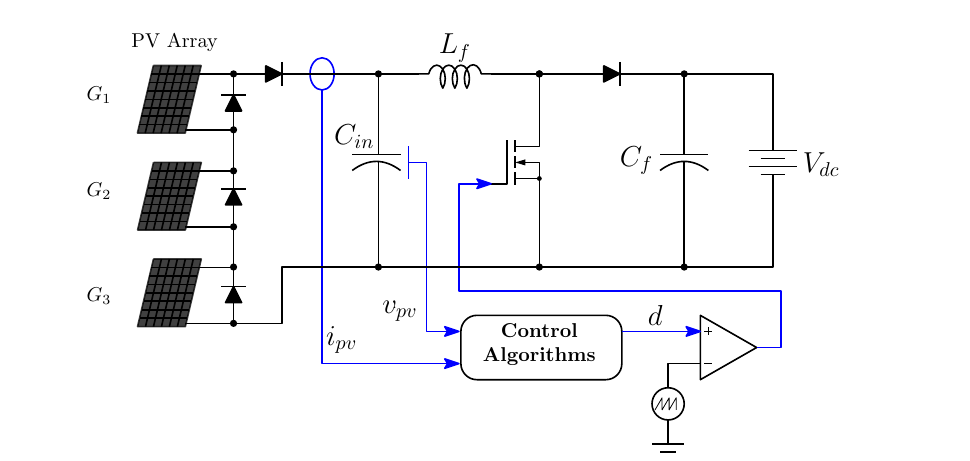
Figure 4. Simplified electrical scheme of the simulated